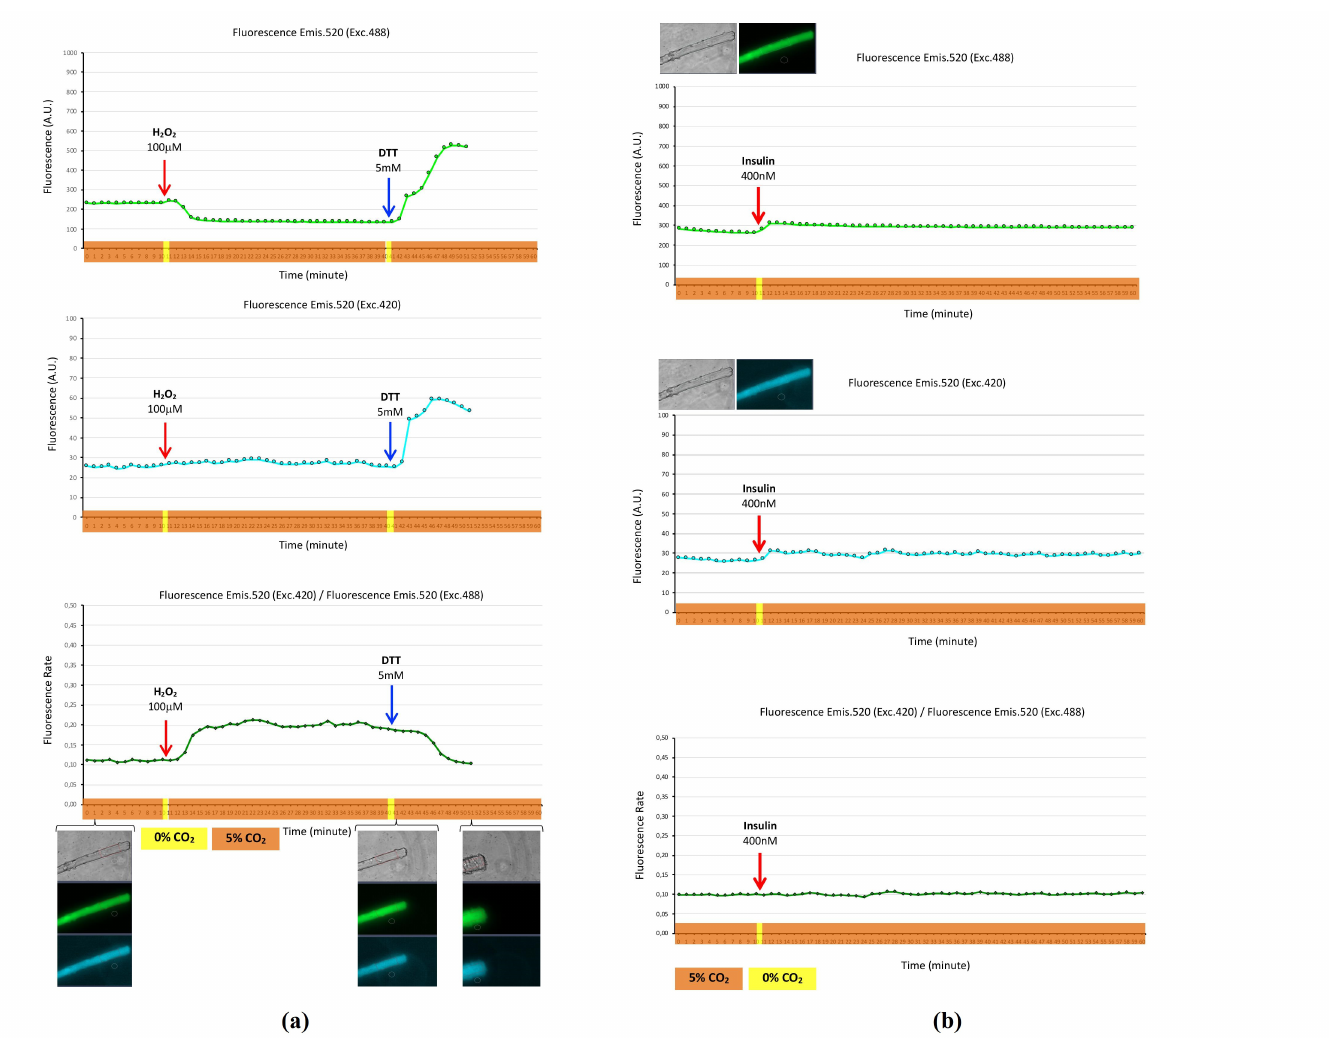
Figure 4. Hydrogen peroxide biosensor roGFP2-Orp1 expressed in the cytosol of single skeletal muscle fibers. Fluorescence monitoring during a time course of 60 min and fluorescence image registration every minute. Fibers were maintained at 37 ◦ C in a 5% CO 2 atmosphere (timeline highlighted in orange), with the exception of the timepoints in which reagents (100 µ M of H 2 O 2 or 5 mM of DTT) were incorporated into the fiber medium and the fibers were maintained at 37 ◦ C in a 0% CO 2 atmosphere for 40 s (timeline highlighted in yellow), the time needed to add reagents. H 2 O 2 (100 µ M final) and DTT (5 mM final) were added into the fiber medium just after the 10 and 40 min timepoints, respectively. ( a ) Top panel presents the fluorescence, in arbitrary units (A.U.), of the roGFP2-Orp1 biosensor fluorescence emission at 520 nm when excited at 488 nm of the fiber that expressed roGFP2-Orp1. Middle panel presents the fluorescence emission at 520 nm when excited at 420 nm. Bottom panel is the fluorescence rate (fluorescence emission at 520 nm when excited at 420 nm divided by fluorescence emission at 520 nm when excited at 488 nm). Sets of fiber images: Transmission (grey), green fluorescence (emis. 520, exc. 488), and blue fluorescence (emis. 520, exc. 420) at timepoints 1, 41, and 51 min, the area of the fiber selected for fluorescence quantification and the area of the background fluorescence where is shown; ( b ) top panel: Fluorescence, in arbitrary units (A.U.), of the roGFP2-Orp1 biosensor fluorescence emission at 520 nm when excited at 488 nm of the fiber that expressed roGFP2-Orp1—transmission and fluorescence images with areas selected for fluorescence quantification are shown. Similarly, the middle panel presents the fluorescence emission at 520 nm when excited at 420 nm. Bottom panel is the fluorescence rate (fluorescence emission at 520 nm when excited at 420 nm divided by fluorescence emission at 520 nm when excited at 488 nm). Insulin was added into the fiber medium (400 nM final) just after the 10 min timepoint. (Supplementary enlarged